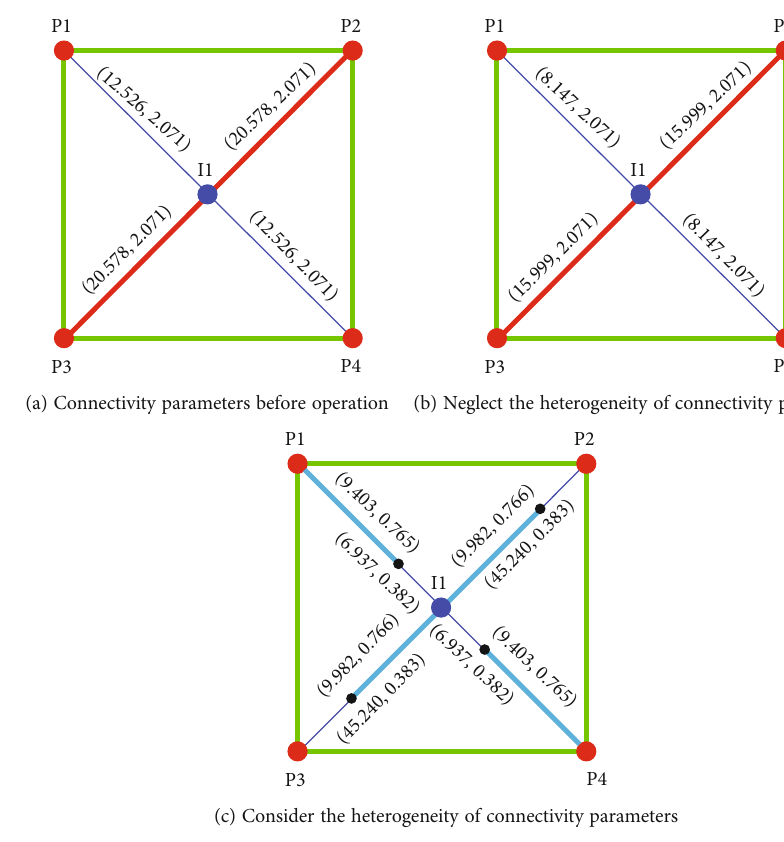
Figure 6: Distribution of connectivity parameters in di ff erent